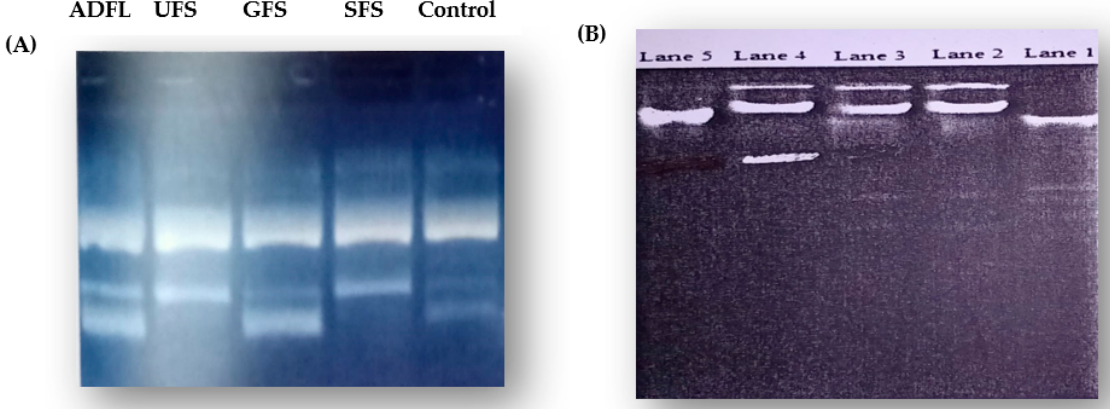
Figure 1. ( A ) DNA fragmentation analysis using agarose gel electrophoresis (AGE). Control: un- treated cell line of HepG2, ADFL: HepG2 treated with IC 50 of air-dried fenugreek seeds, UFS: HepG2 treated with IC 50 of unprocessed fenugreek seeds, GFS: HepG2 treated with IC 50 of germinated fenugreek seeds, SFS: HepG2 treated with IC 50 of soaked fenugreek seeds. ( B ) DNA fragmentation using agarose gel electrophoresis. Lane 5: untreated cell line (control) of MCF-7, Lane 4: MCF-7 treated with IC 50 dose of air-dried fenugreek seed (ADFL) sample, Lane 3: MCF-7 treated with IC 50 dose of unprocessed fenugreek seed (UFS) sample, Lane 2: MCF-7 treated with IC 50 dose of germinated fenugreek seed (GFS) sample, Lane 4: MCF-7 treated with IC 50 dose of soaked fenugreek seed (SFS)